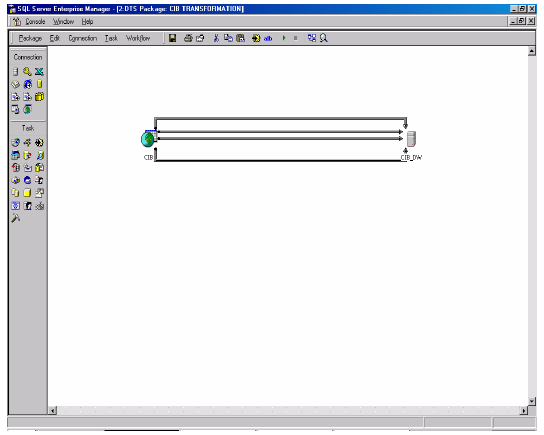
Figure 3: Data Transformation, Extraction and Loading